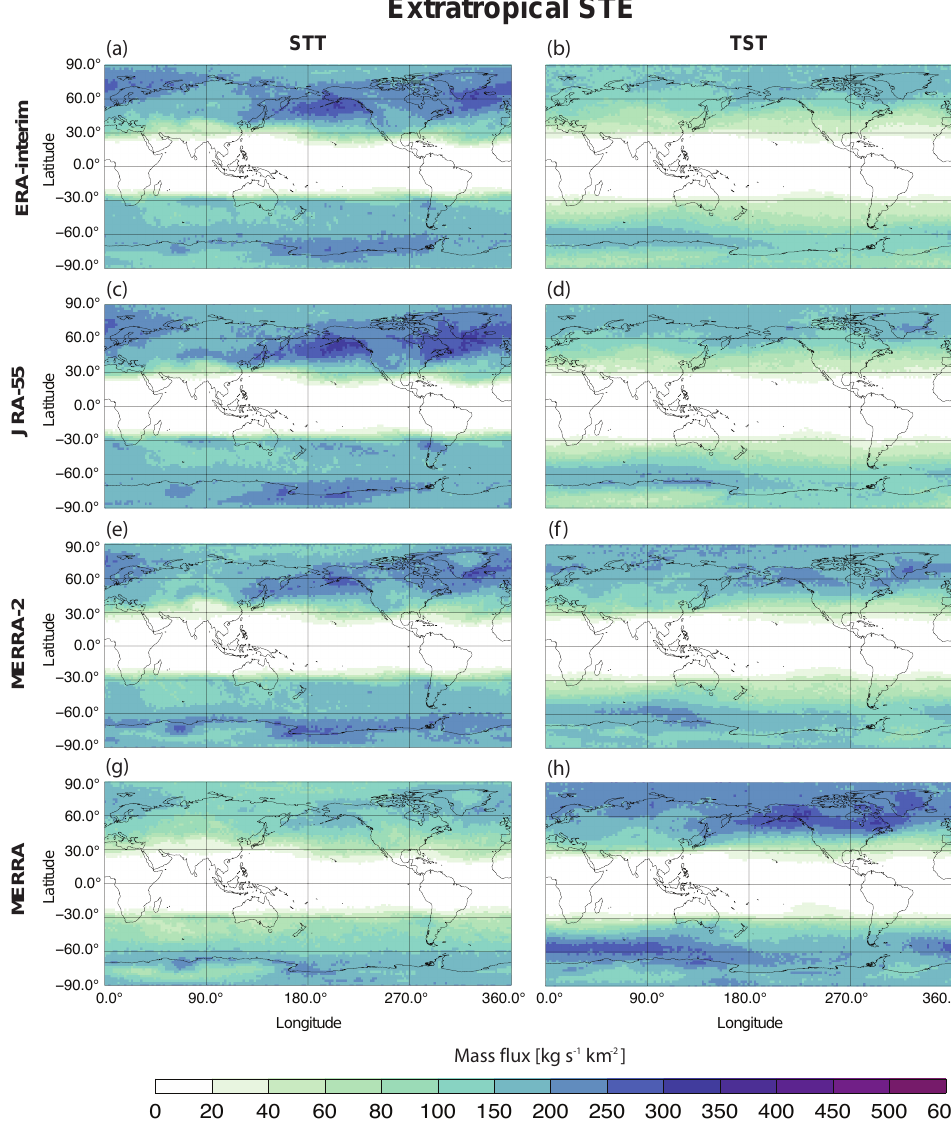
Figure 5. The same as in Fig. 4 but for STE in the